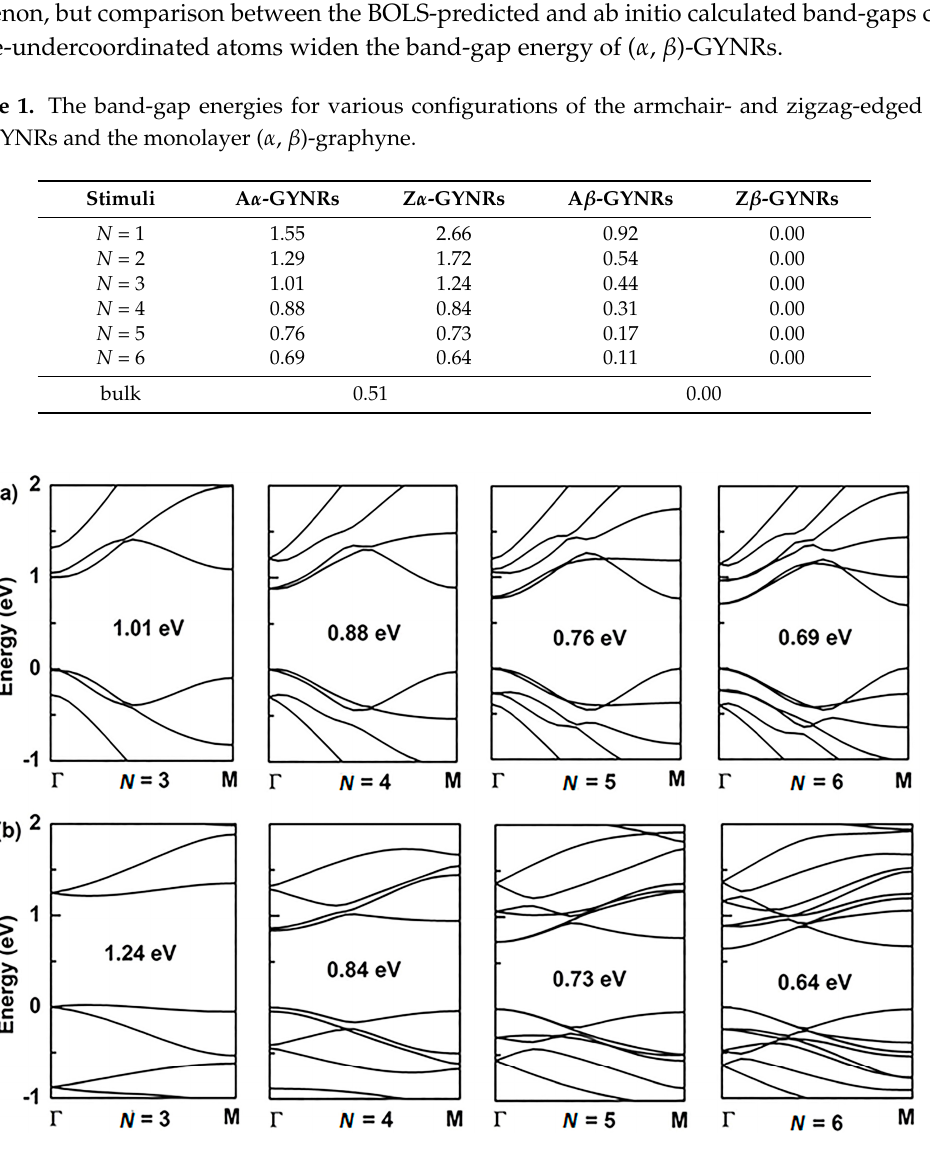
Figure 4. The band structure of armchair-edged α -graphyne nanoribbons with ( a ) N = 3 to 6, and zigzag-edged α -graphyne nanoribbons with ( b ) N = 3 to 6. The Fermi level is set to zero.